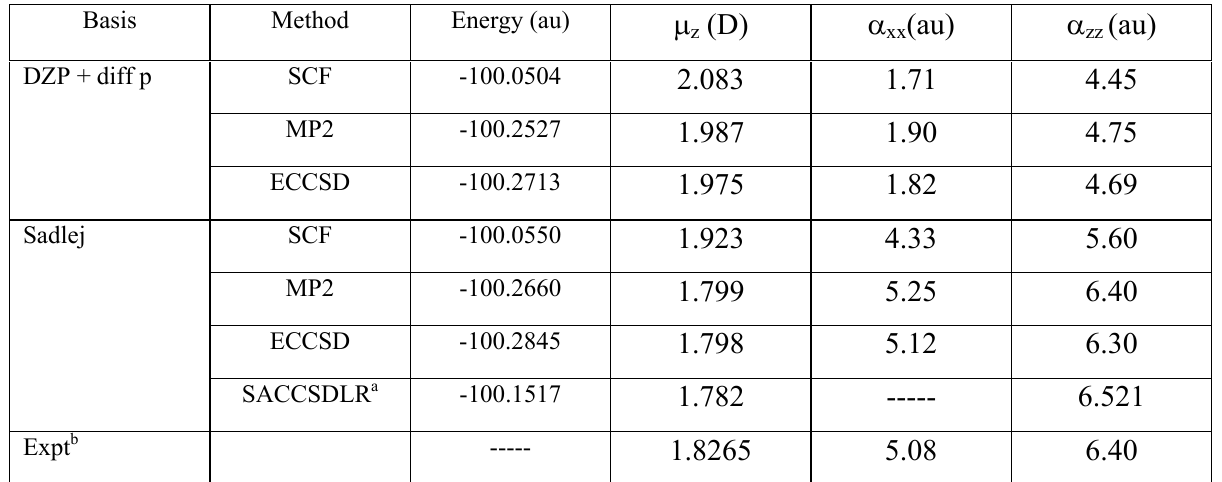
Table 3. Properties of Hydrogen Fluoride in different